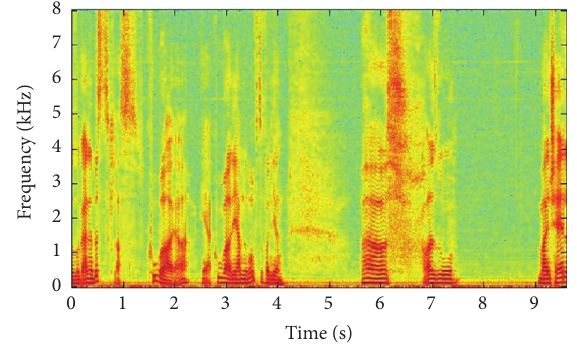
Figure 2: Spectrogram sample